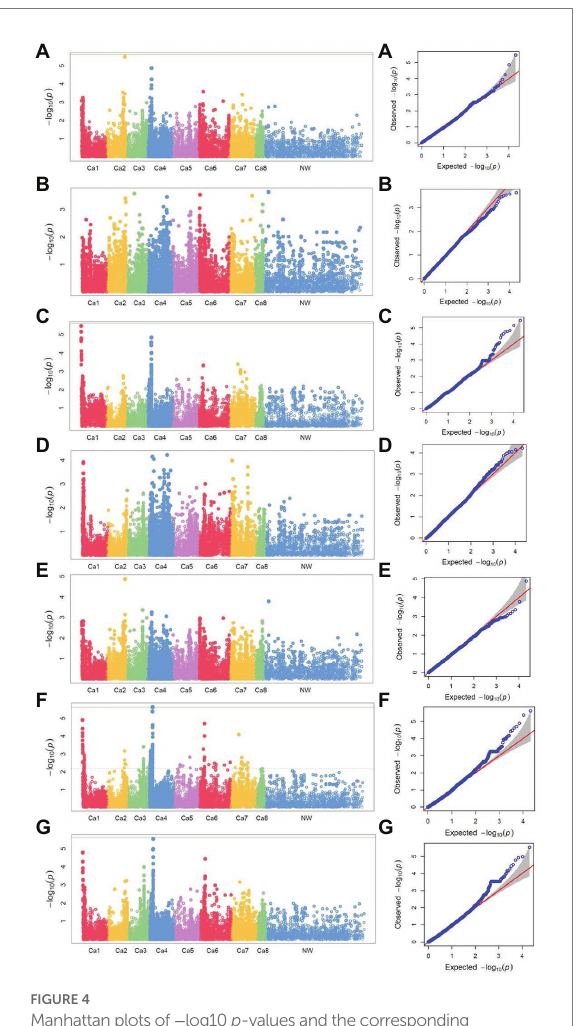
FIGURE 4 Manhattan plots of − log10 p- values and the corresponding quantile–quantile (Q–Q) plots of the association analysis for (A) seed yield under non-stress and (B) seed yield under stress conditions and yield indices (C) ATI, (D) K 1 STI, (E) MP, (F) SSPI, and (G) TOL using a mixed linear model for four locations: Lucky Lake and Moose Jaw, Saskatchewan, 2019, Yuma, Arizona, 2019–2020, and Lucky Lake, Saskatchewan, 2020. For Manhattan plots: y -axis, − log10 p -values; x -axis, chromosome numbers. For Q–Q plots: y -axis, observed − log10 p -values; x -axis, expected − log10 p